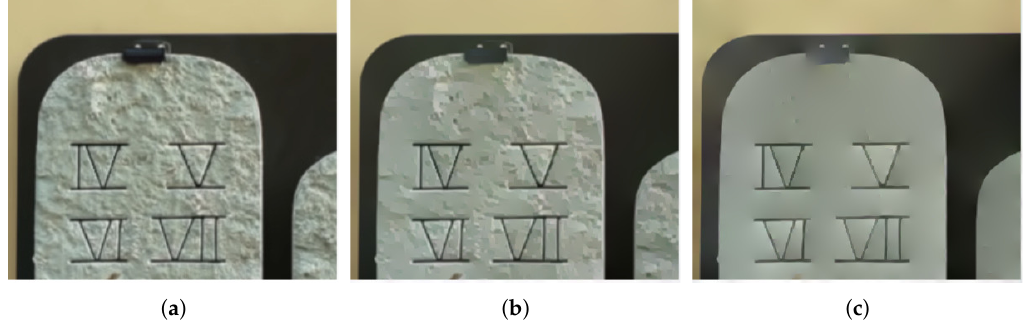
Figure 3. Output of (5) with different λ . ( a ) Input; ( b ) output using λ = 5; ( c ) output using λ =